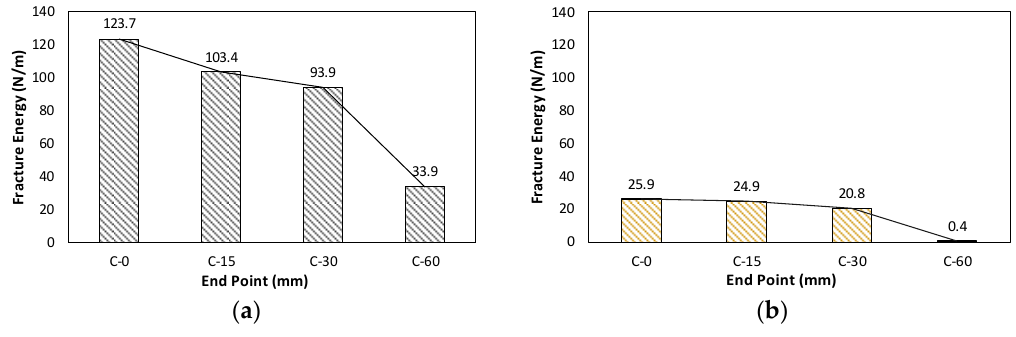
Figure 14. Comparison of Load–CMOD curves: ( a ) elapsed time to meet new layer (30 min); and ( b ) elapsed time to meet new layer (60 min).